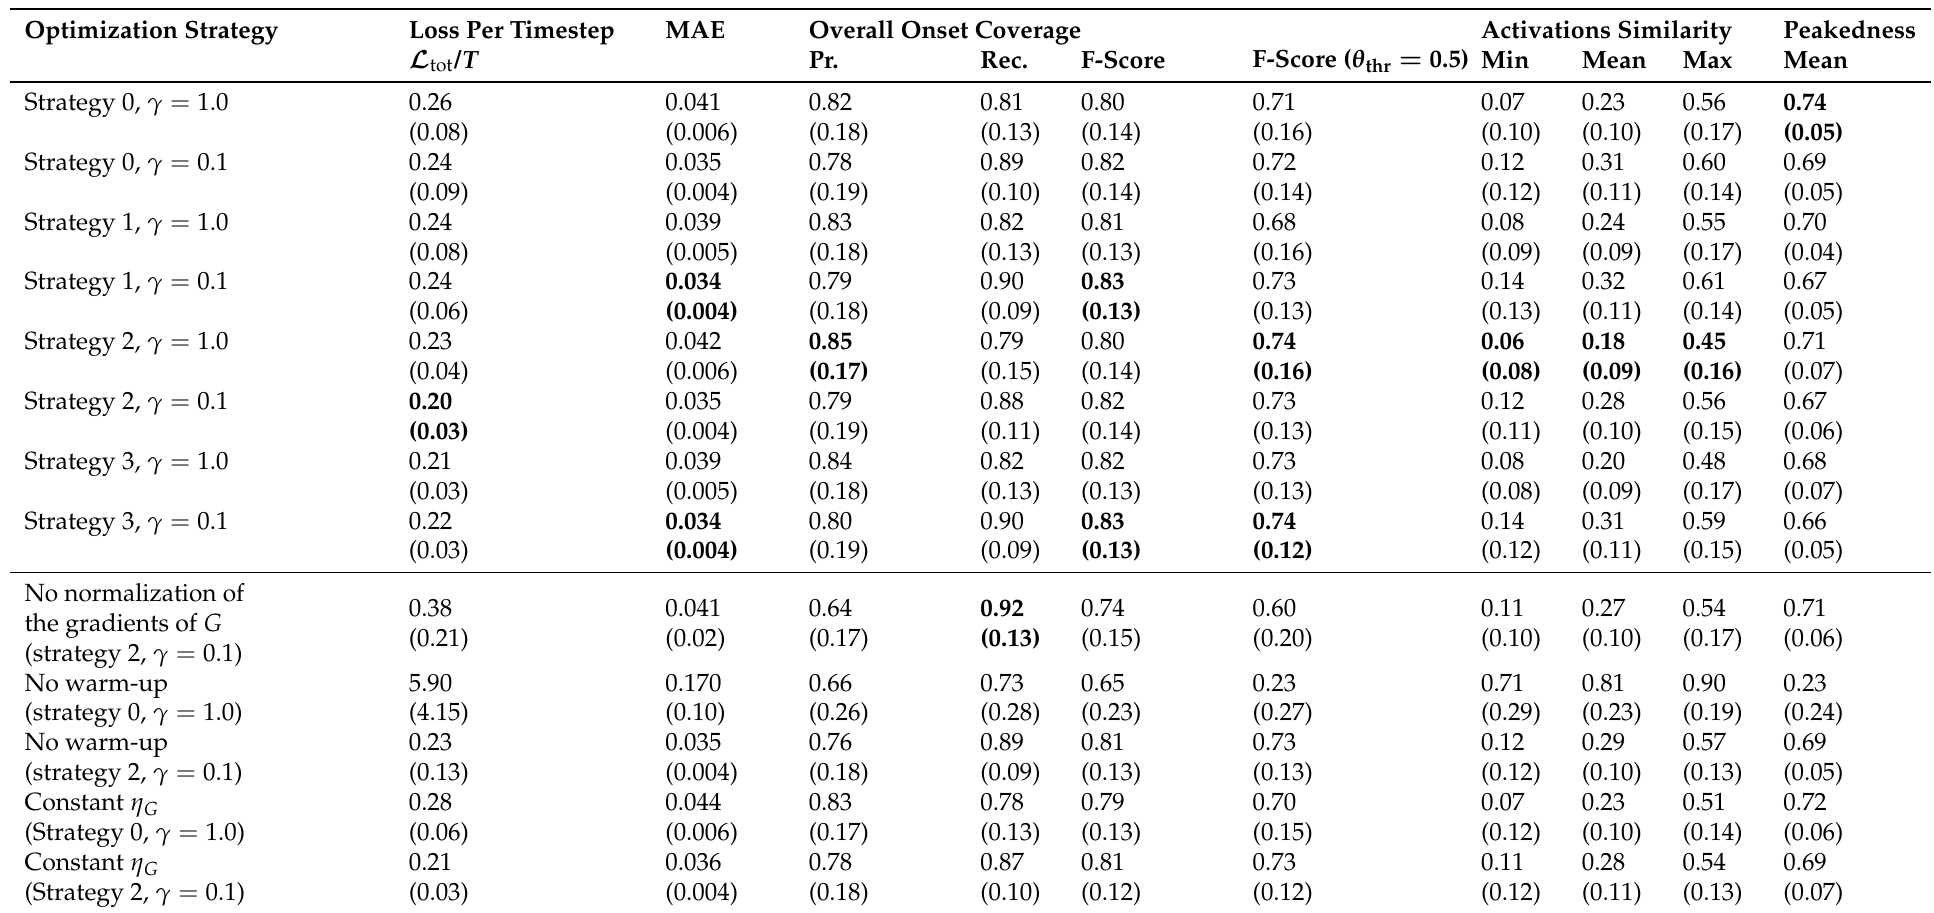
Table 2. Optimization strategy evaluation results: comparison of the metrics evaluated on the outcome of each optimization strategy. For each metric, the mean value over all 135 phrases is shown (standard deviation between parentheses). For each metric, the most optimal value is shown in bold in each